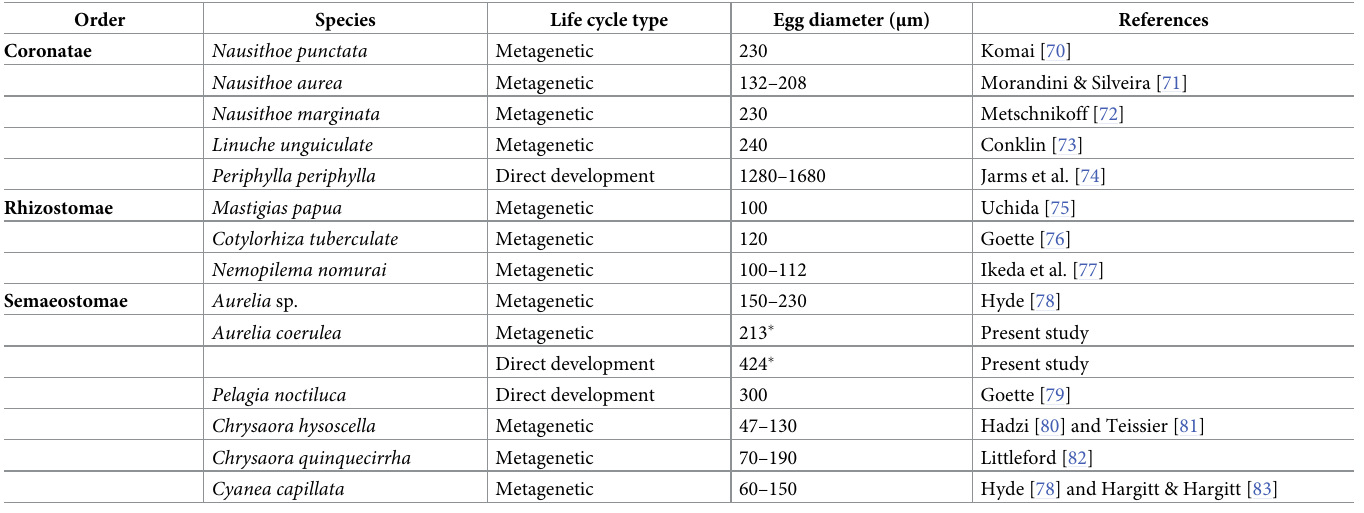
Table 1. Life cycle type of Scyphozoa in relation to their egg